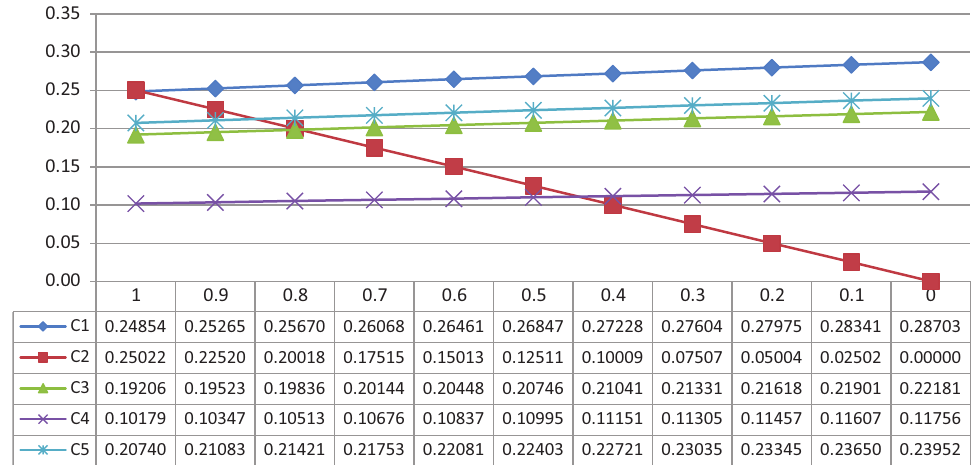
Figure 6. Results of the sensitivity analysis for the factor Travel Safety and Accident Reduction Measures